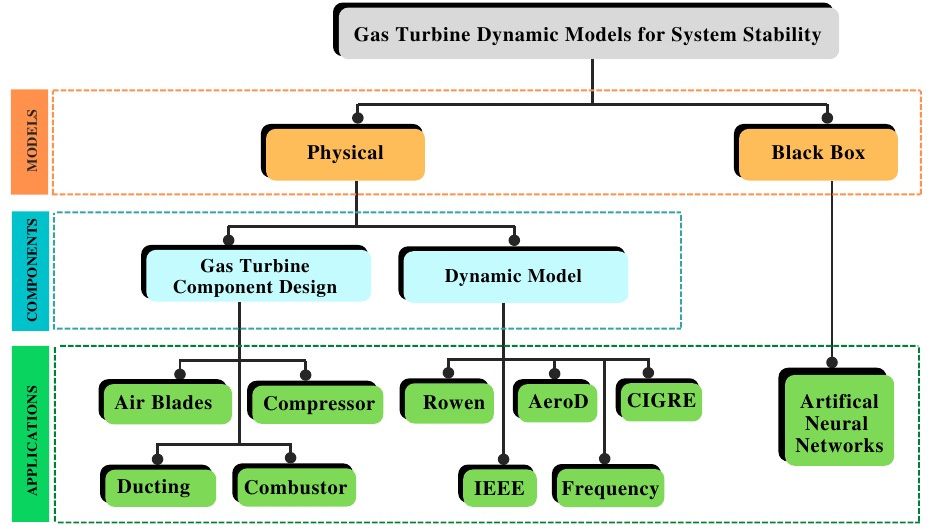
Figure 13. Gas turbine dynamic models for system